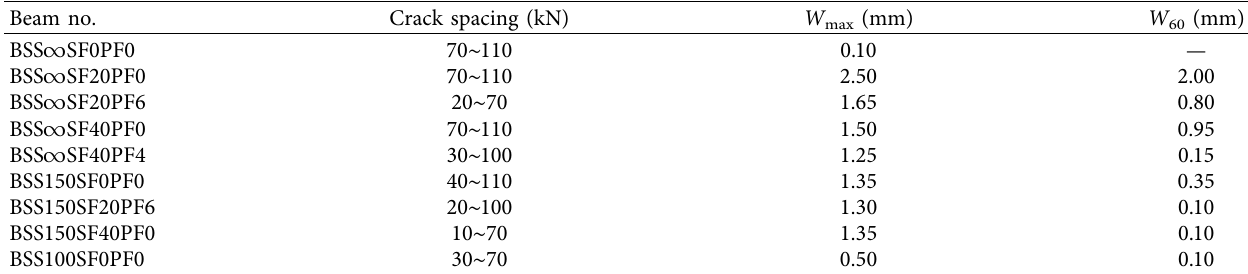
Table 5: Crack characteristics of shear span of beams.